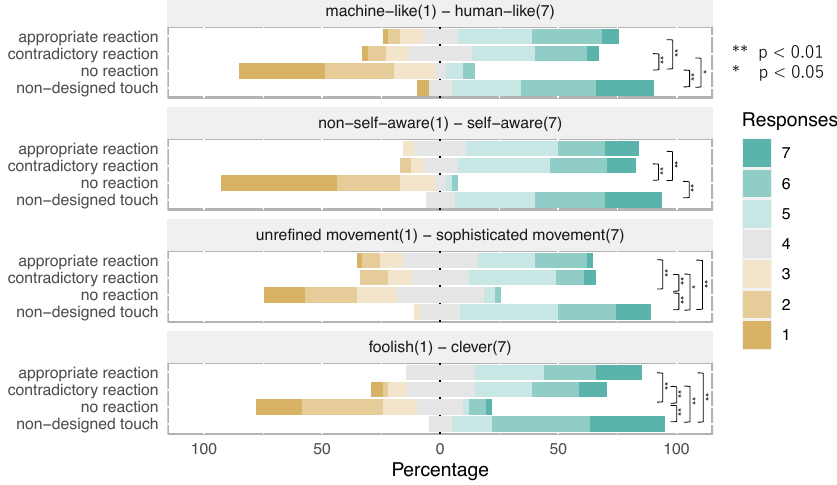
Figure 6. Results of questionnaire responses after each session (2/4): robot’s humanity and intelligence.